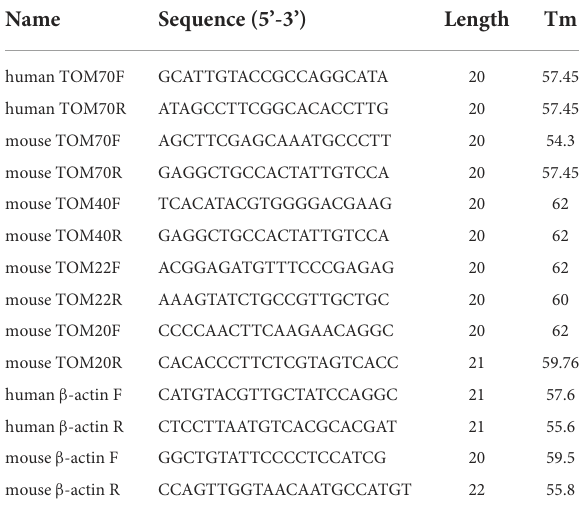
TABLE 1 Oligonucleotide primer sets for